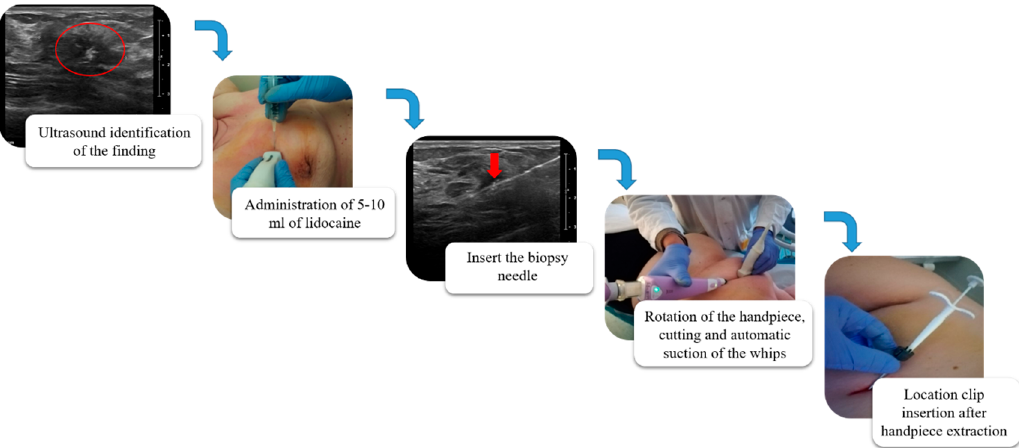
Figure 2. Workflow of the VABB Elite procedure. The biopsy finding is initially identified on the